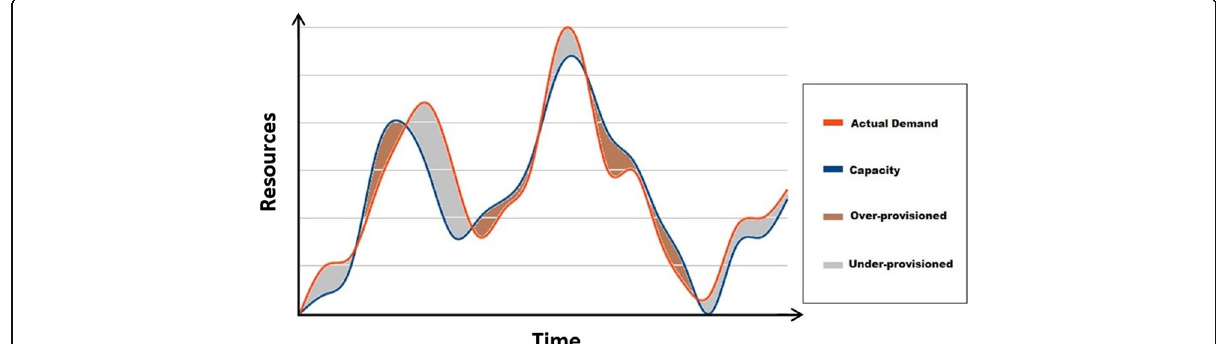
Fig. 1 Key concepts for measuring